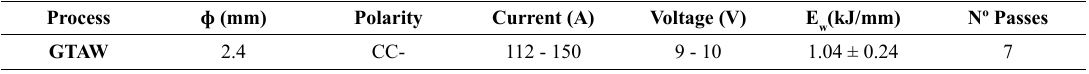
Table 3. Welding parameters and average welding energy.